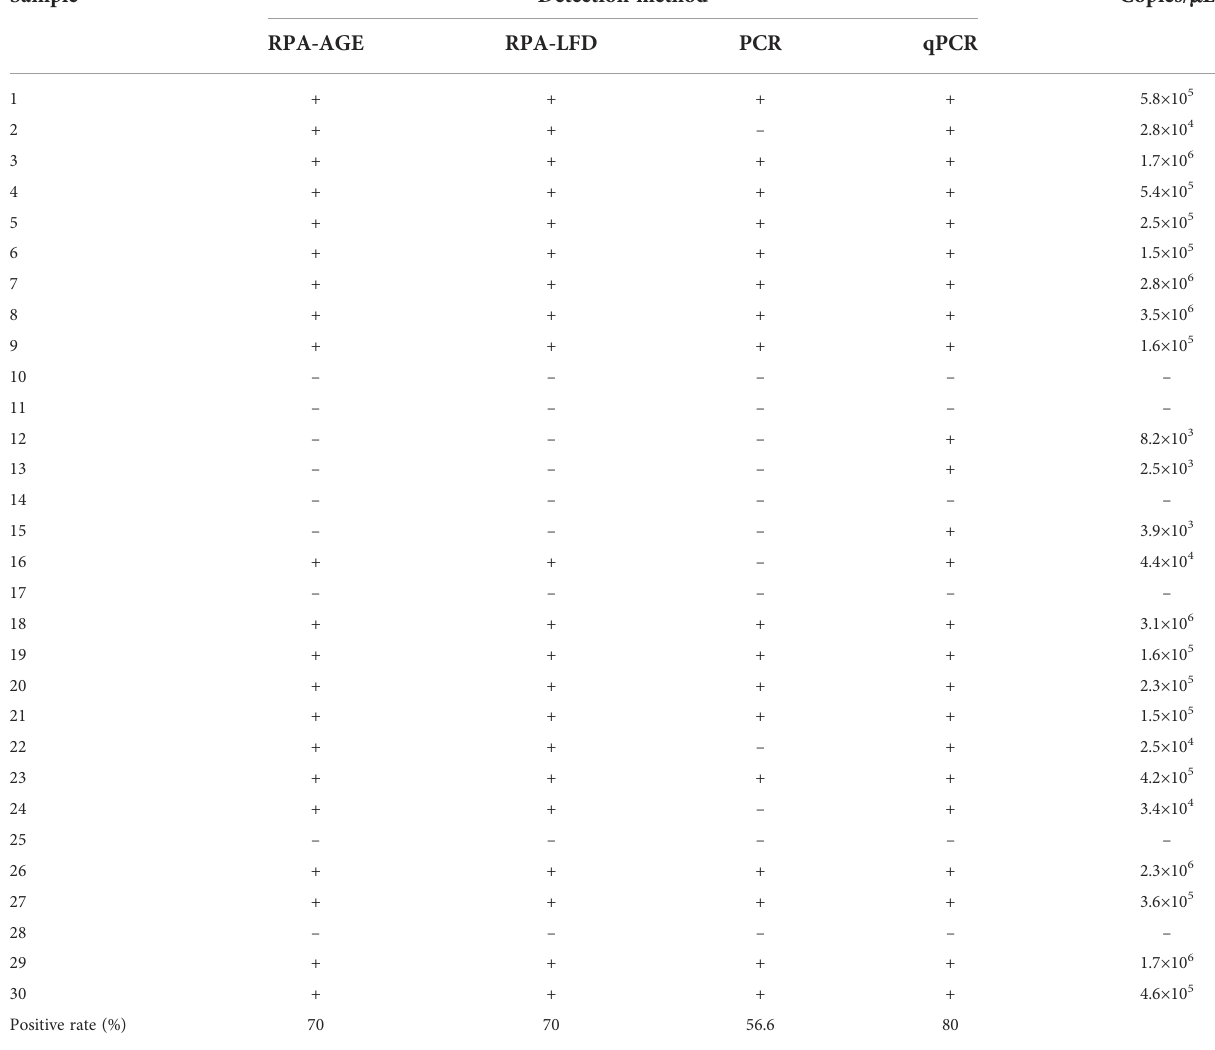
TABLE 3 Sample detection results by RPA-AGE, RPA-LFD, PCR, and qPCR methods. Sample